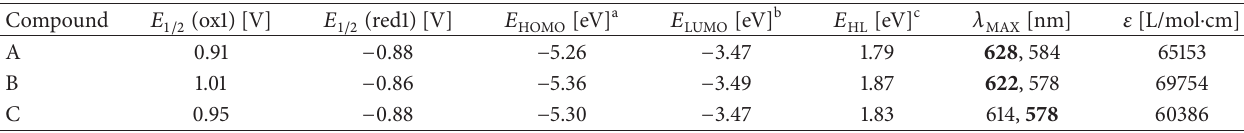
Table 1: The first half-wave ( 𝐸 1/2 ) oxidation (Ox1) and reduction (Red1) potentials obtained from rotating disk voltammetry recomputed [31] to frontier orbital energy levels. Absorption maxima 𝜆 MAX of 0-0 and 0-1 vibronic subbands of the longest wavelength band (absolute maxima are in bold and relate to molar absorptivities 𝜀 ).